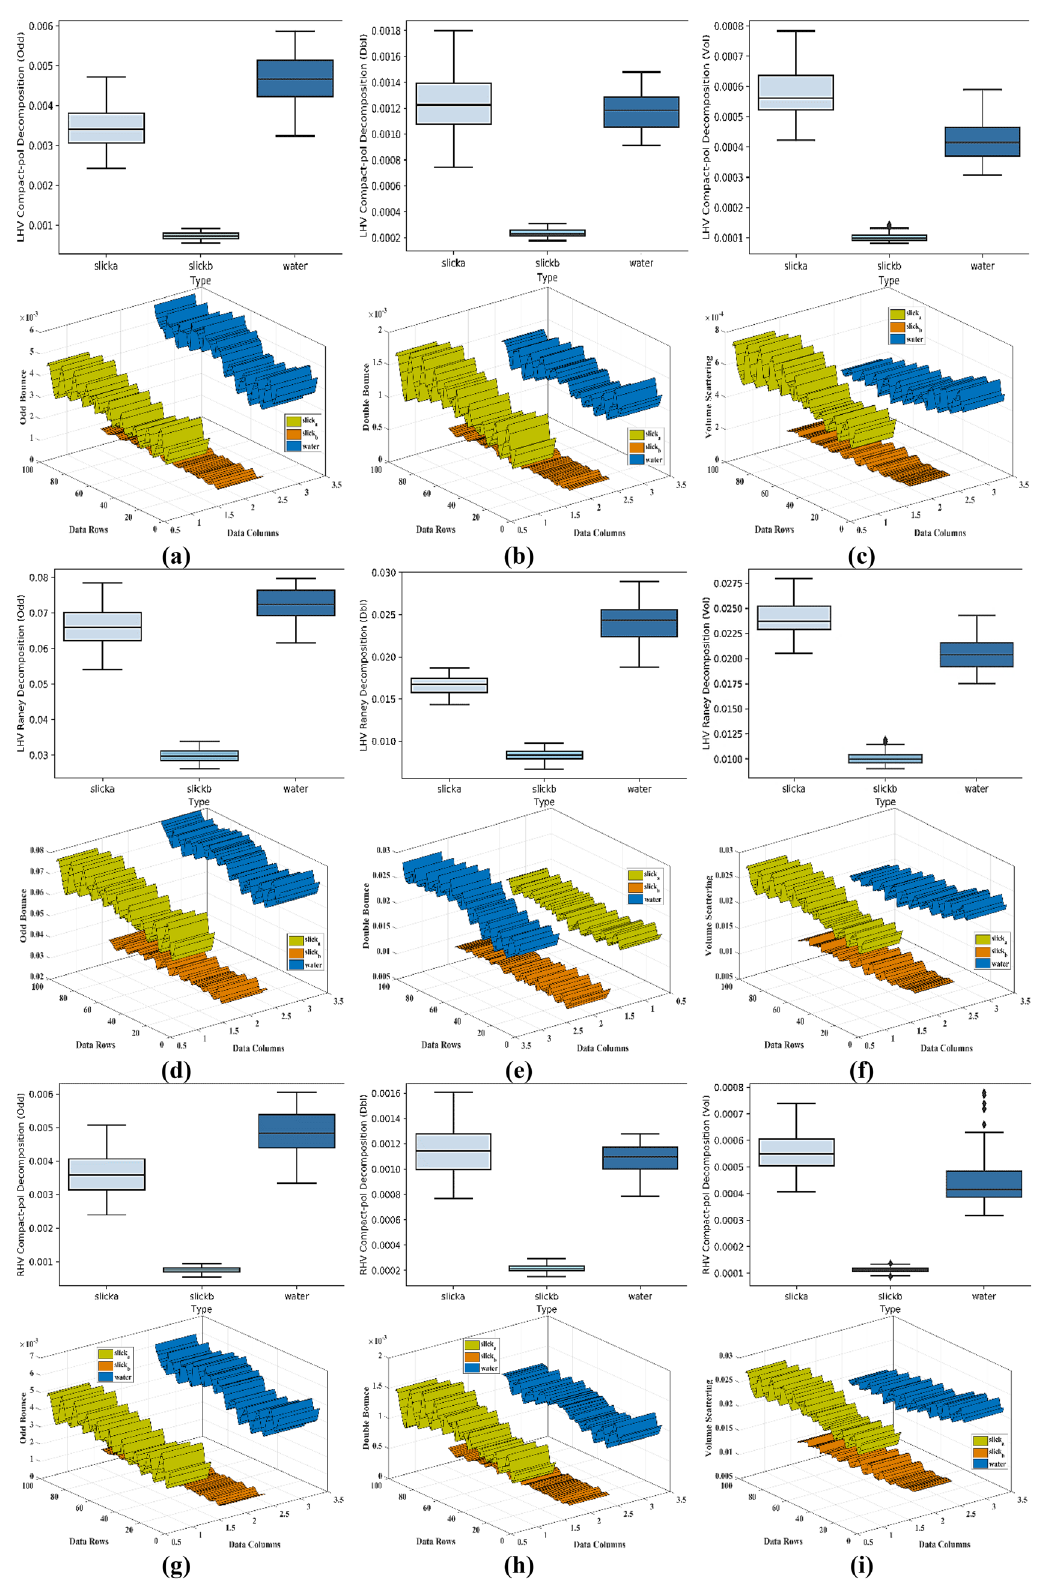
Figure 8. Extracted Box-whiskers and respective separability plots for slick a , slick b and water regions for ( a – c ) LHV Compact-pol Decomposition, ( d – f ) LHV Raney Decomposition, ( g – i ) RHV Compact-pol Decomposition and, ( j – l ) Coherency